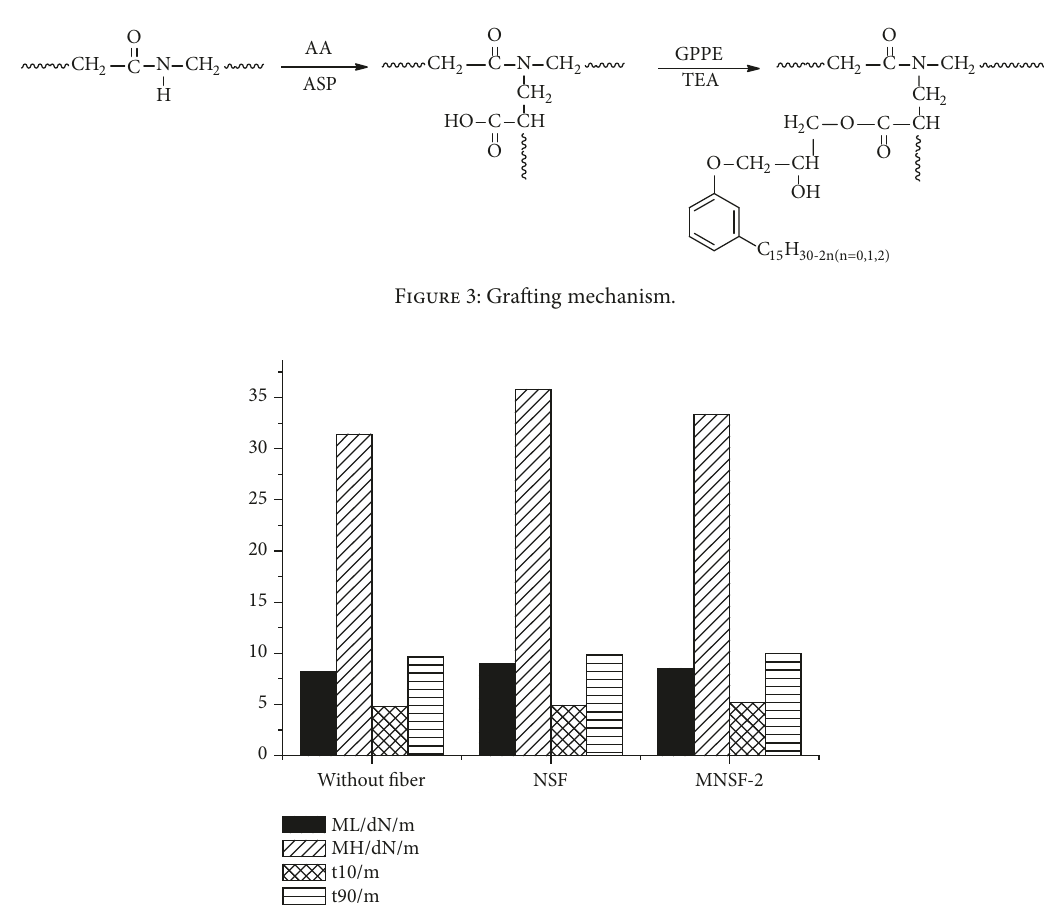
Figure 4: Effects of short fibers on cure characteristics of tread